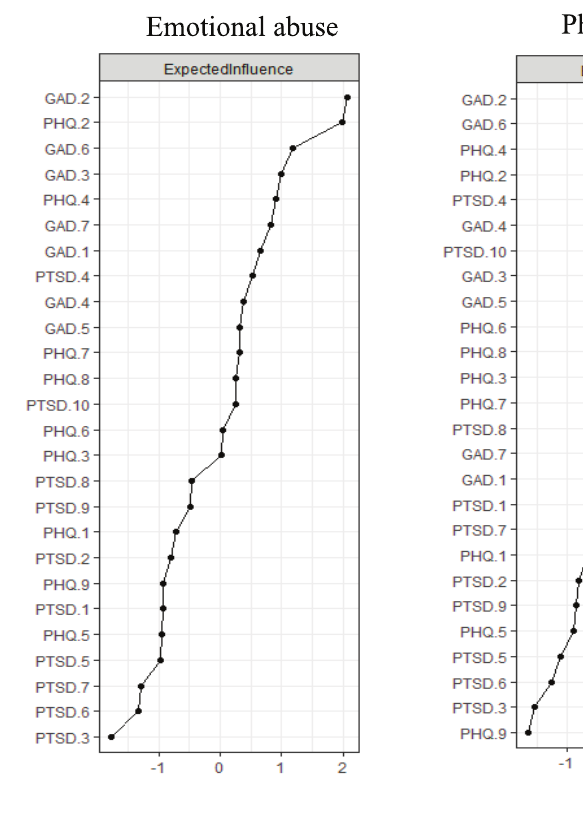
FIGURE2 Expected influence of each node in the networks among participants with emotional abuse, physical abuse and sexual